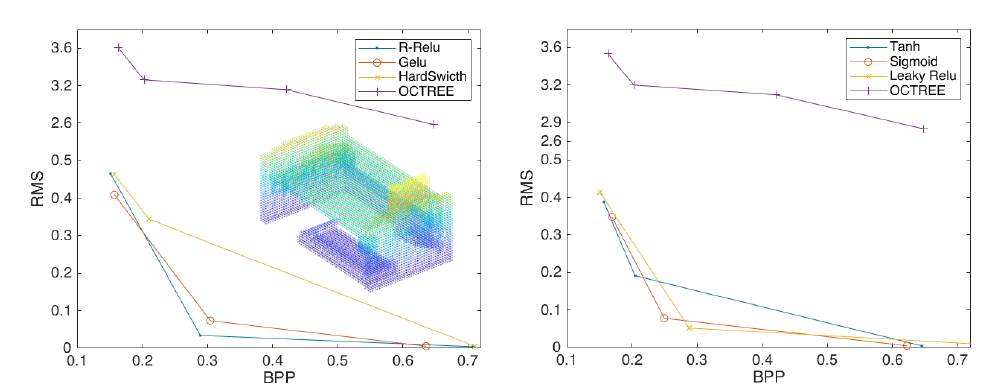
Figure 8. The compression performance of the scheme configured with two layers of convolution and two strides, using the activation functions R-Relu , Gelu , and HardSwitch ( left ) and Tanh , Sigmoid , and Leaky Relu ( right ).